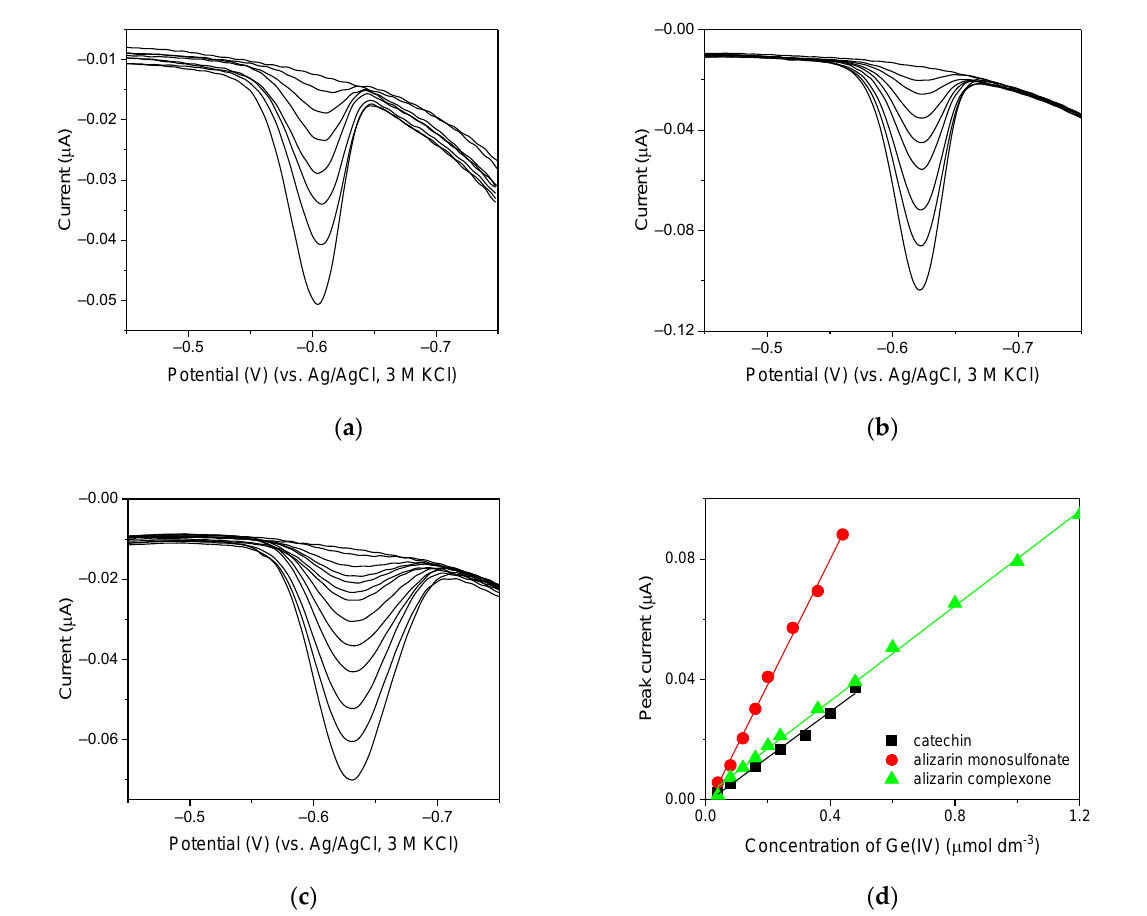
Figure 15. DP catalytic voltammetric curves of germanium with increasing Ge(IV) concentration ranging from ( a ) 0.04 µM to 0.48 µM of Ge(IV), ( b ) 0.04 µM to 0.52 µM of Ge(IV) and ( c ) 0.04 µM to 1.20 µM of Ge(IV), recorded using HMDE in the presence of ( a ) 2 µM of catechin, ( b ) 2 µM of alizarin sodium monosulfonate, and ( c ) 2 µM of alizarin complexone, 0.8 mM of V(IV), 1.6 mM of HEDTA and 0.1 M acetate buffer (pH = 4.24). The corresponding calibration plots are shown in panel ( d ). Instrumental parameters: E acc = − 0.2 V, t acc = 30 s.